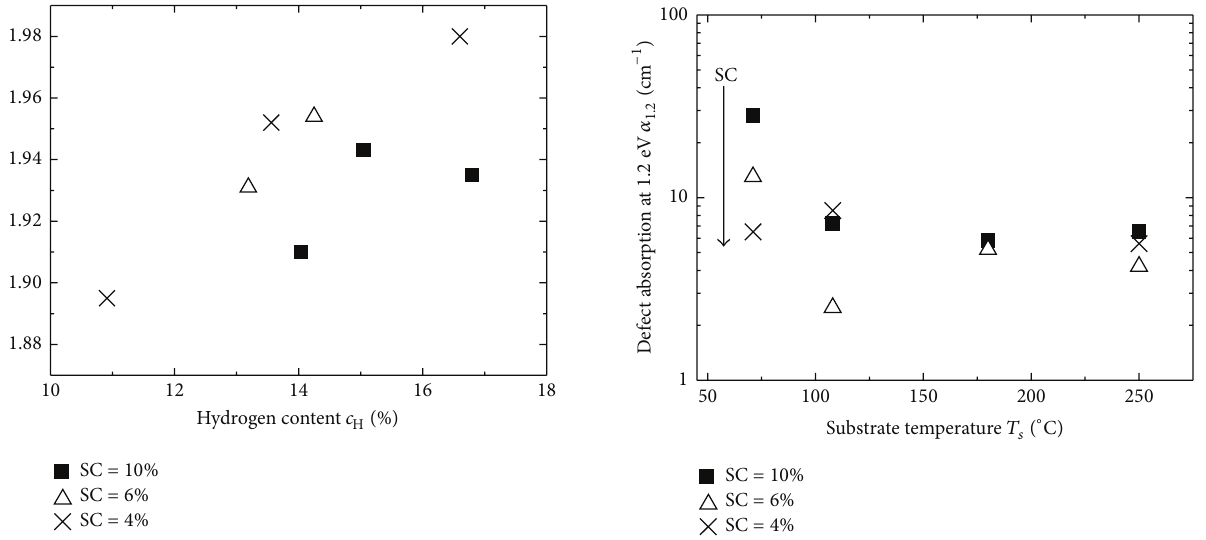
Figure 5: Absorption coefficient at 1.2eV as a function of substrate temperature for different silane concentrations of the intrinsic a- Si:H